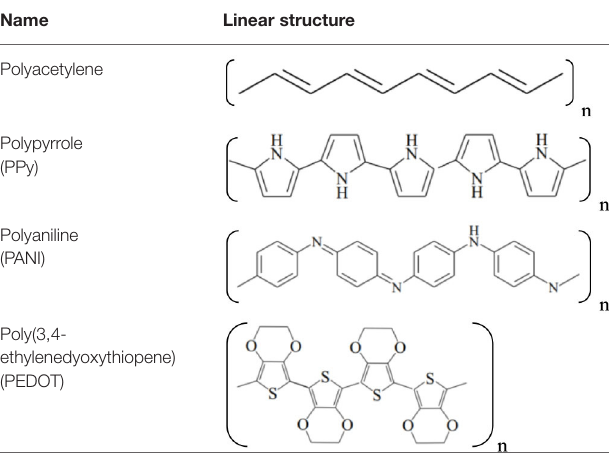
TABLE 1 | Schematic structures of the main conductive